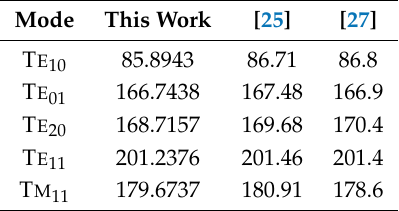
Table 4. Cutoff wavenumbers κ c [ rad · cm − 1 ] for the rectangular waveguide with rounded